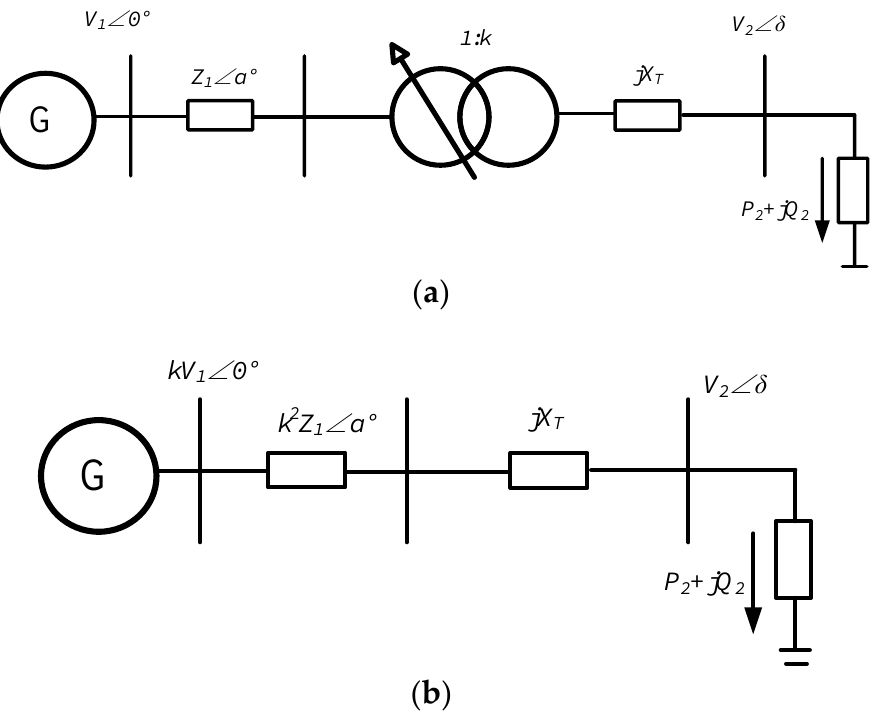
Figure 5. Simple system model and equivalent model with OLTC transformer. ( a ) The Simple Circuit of a power system with OLTC transformer ( b ) The Equivalent model with OLTC transformer.